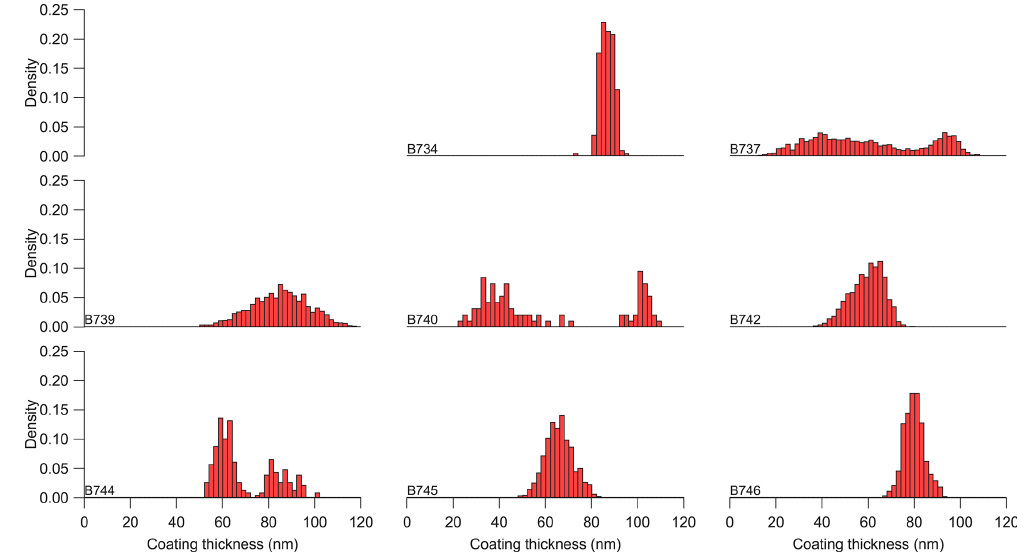
Figure 12. Histograms of refractory black carbon coating thickness from the regional analysis across individual